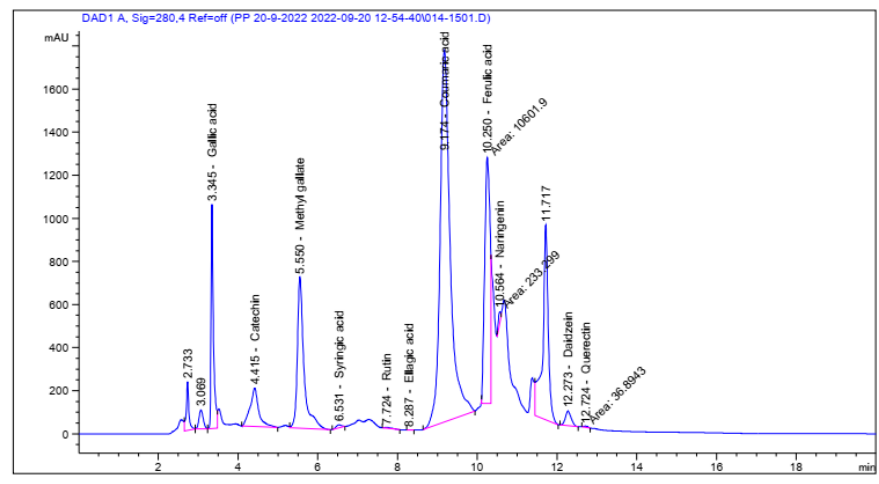
Figure 1. HPLC chromatogram of P. zonale leaves extract. Table 1. Identification of Phenolic compounds of P. zonale leaves extract by HPLC. Compound